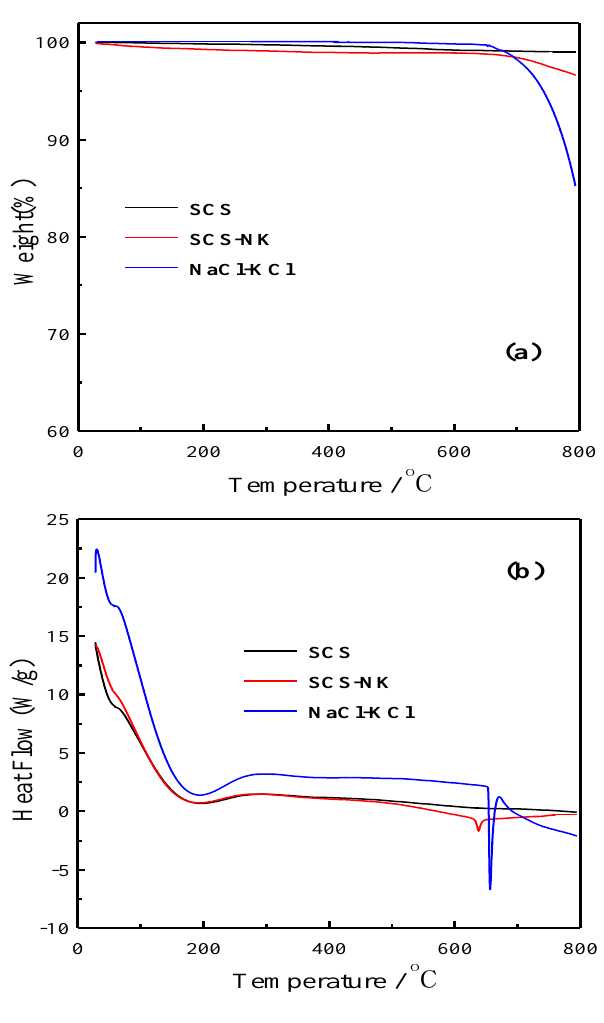
Figure 3. ( a ) TGA, ( b ) DSC curves of the SrCe 0.9 Sm 0.1 O 3-α (SCS), SrCe 0.9 Sm 0.1 O 3-α -NaCl-KCl (SCS-NK) and NaCl-KCl powder in nitrogen up to 800 °C.